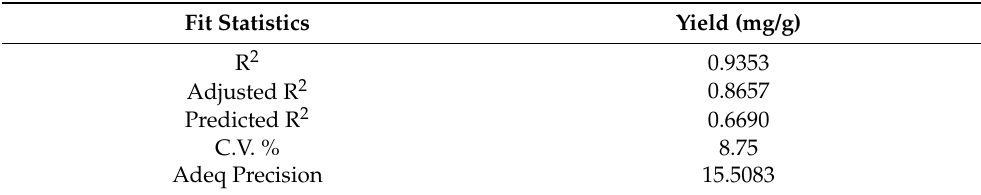
Table 3. Analysis of variance for the fitted models (Fit